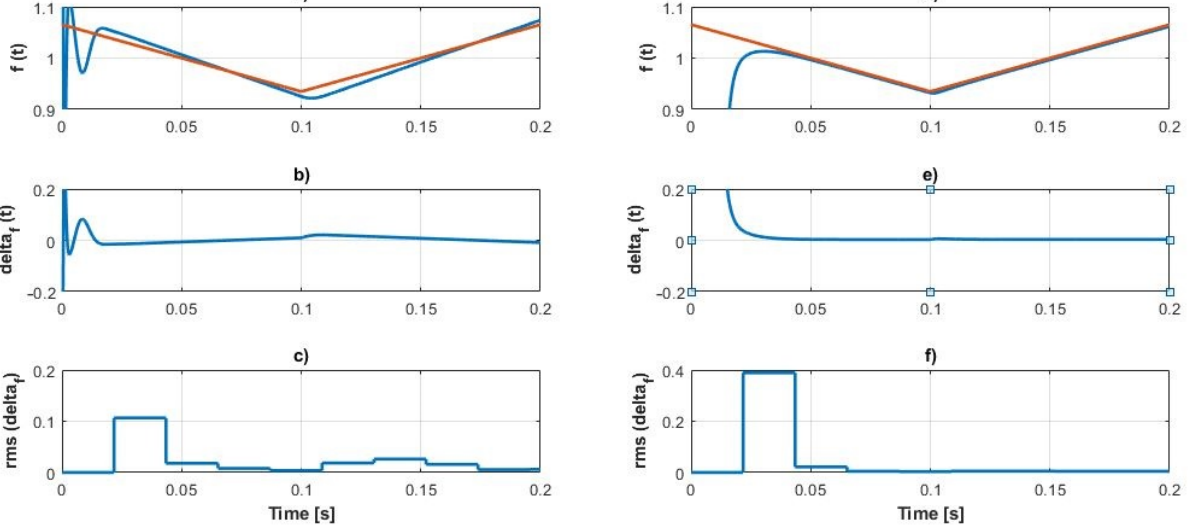
Figure 10. Frequency swing for ± 3 Hz deviation and slew rate 60 Hz/s. RFE ( a – c ) and SRF-FLL ( d – f ), where: ( a , d ) frequency estimated value (orange—reference, blue—tested algorithm), ( b , e ) frequency error between compared algorithms, and ( c , f ) RMS value-form frequency error.